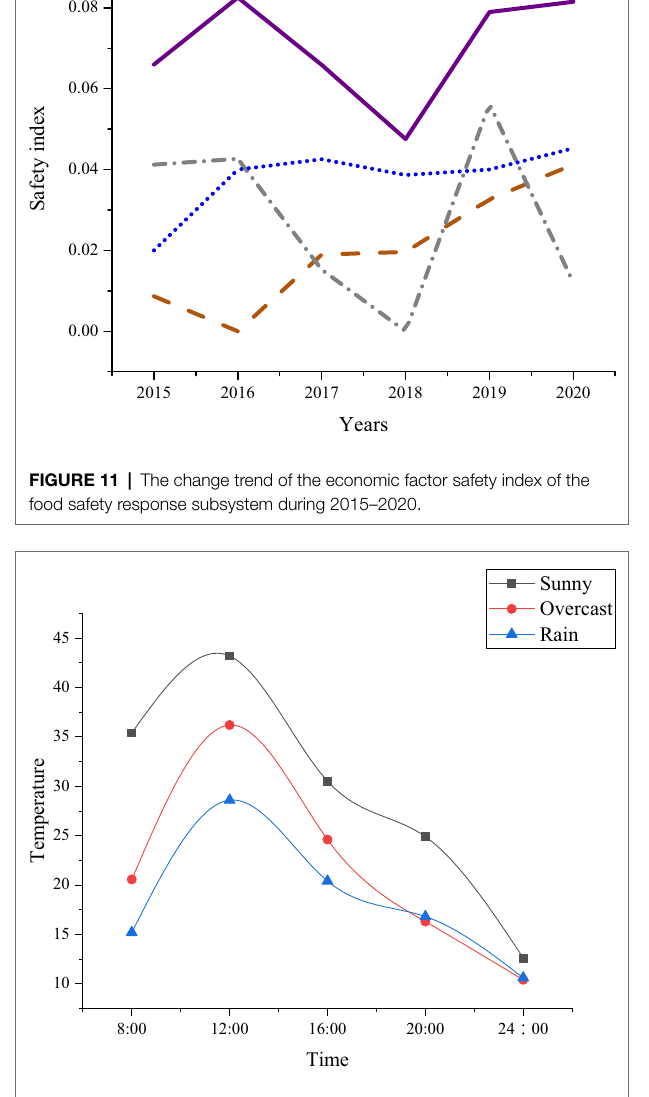
FIGURE 13 | Temperature changes monitored by the Internet of Things (IoT) in greenhouse corn under different